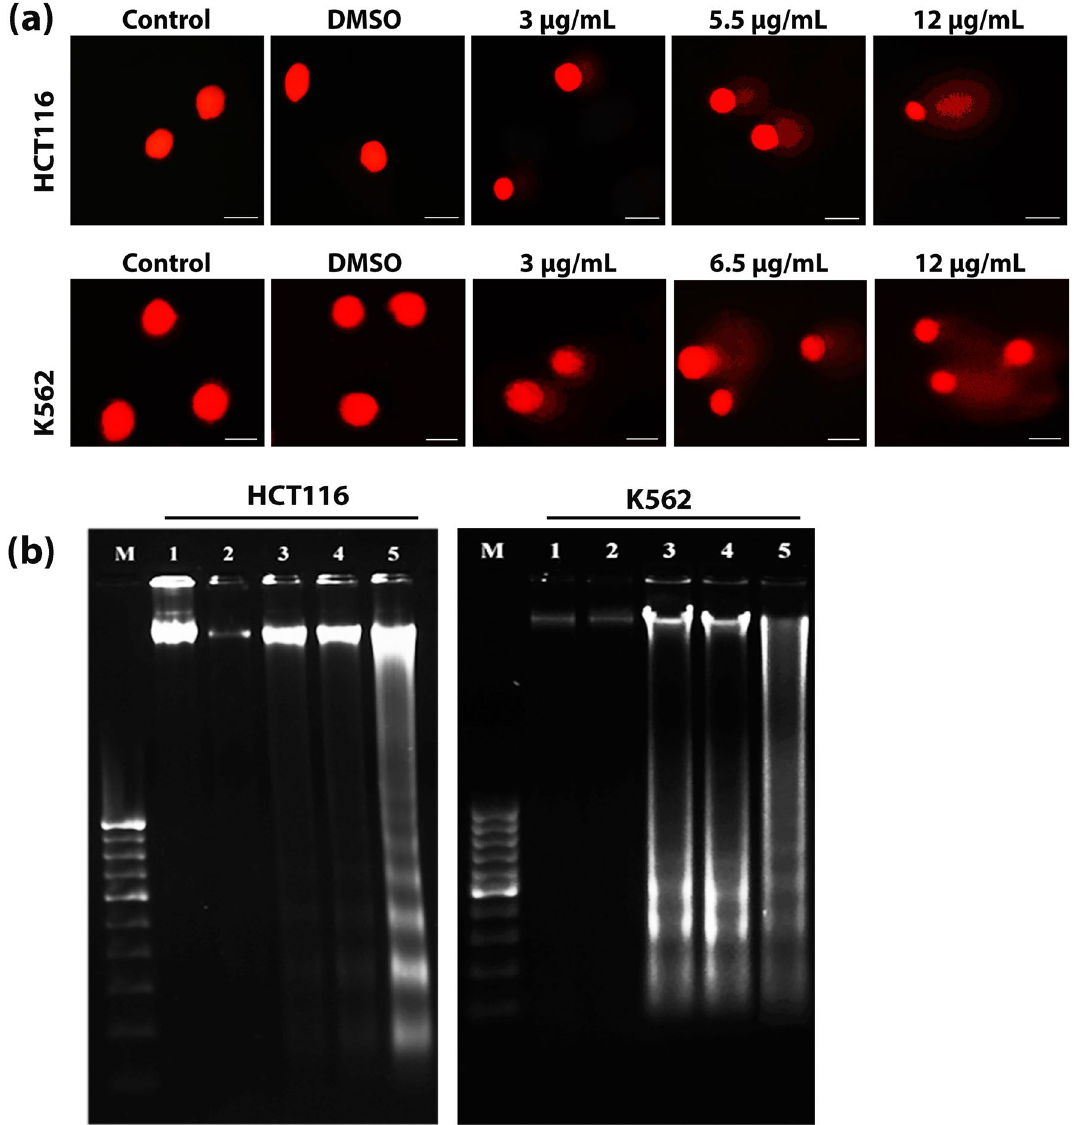
Figure 7. Assessment of CMRP-induced DNA damage in HCT116 and K562 cancer cells. ( a ) Genotoxicity evaluation by alkaline comet assay. ( b ) DNA fragmentation assay, Lane M: 100 bp DNA ladder, Lane 1: DNA from control cells, Lane 2: DNA from DMSO-treated cells, Lane 3: DNA from CMRP (3 µg/mL) treated cells, Lane 4: DNA from CMRP (5.5 µg/mL for HCT116 and 6.5 µg/mL for K562) treated cells, Lane 5: DNA from CMRP (12 µg/mL) treated cells. Full length agarose gels with fragmented DNA are included in Supplementary Figure